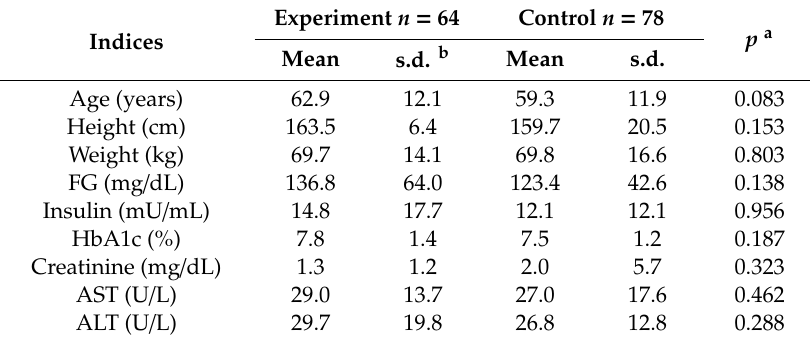
Table 1. Physiological and biochemical indices at the beginning of the